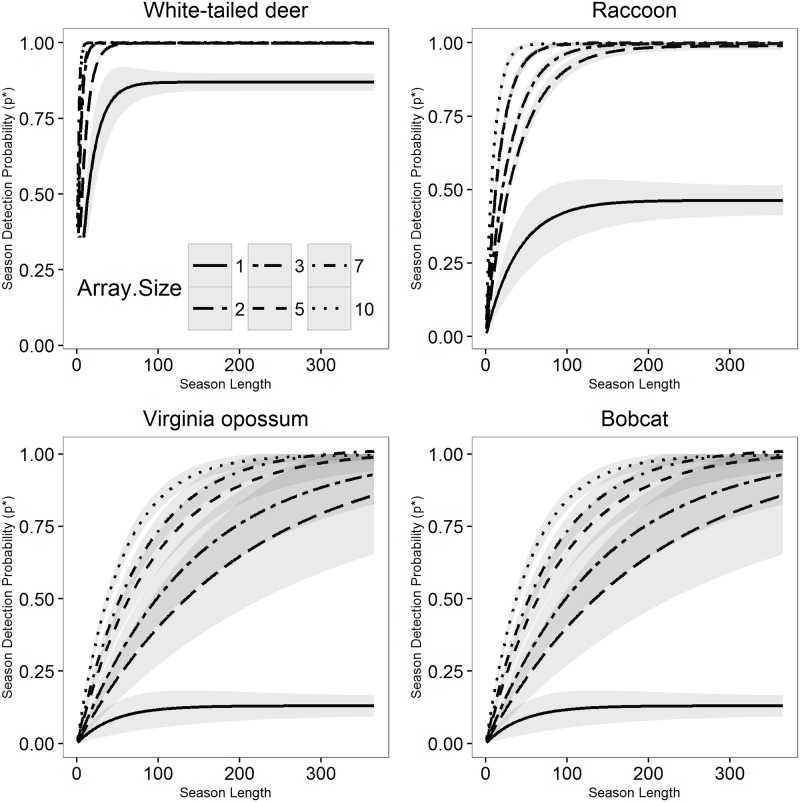
Season detection probability (p*) by season length (0–365 days) and array size (1, 2, 3, 5, 7, 10 cameras; lines) across four species (White-tailed deer, upper left; Raccoon, upper right; Virginia opossum, lower left; Bobcat, lower right), calculated by randomly parsing a yearlong data set with 5,000 Monte Carlo iterations.Lines represent best fit of nonlinear model in R using the NLS package and grey indicates 95% confidence intervals estimated from R package confint. Only a subset of the total array sizes are displayed to improve visual representation of data.